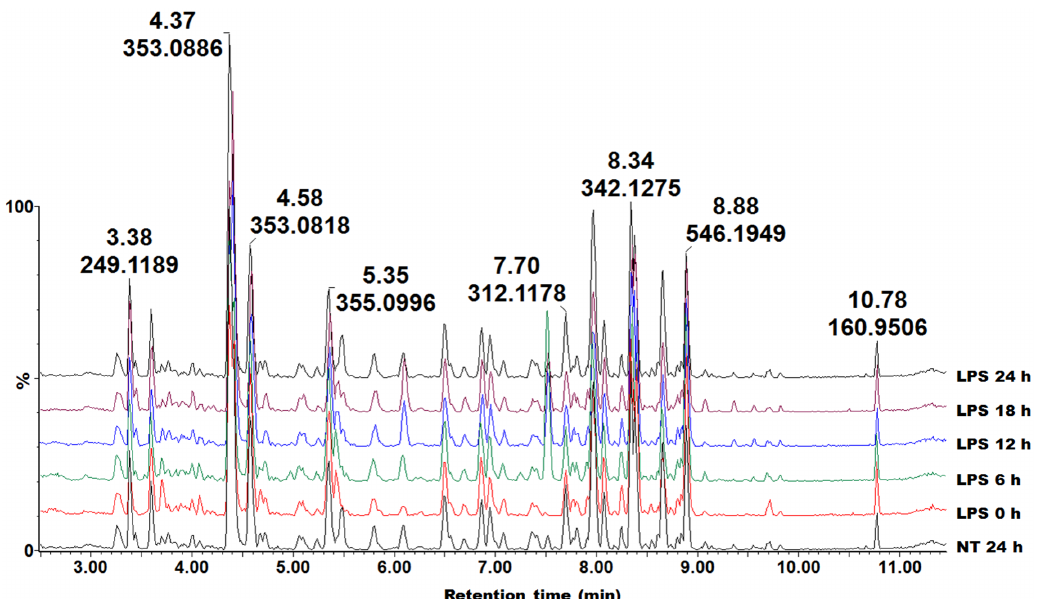
Fig 1. UHPLC-MS BPI chromatograms (ESI - ) of methanol extracts of tobacco cells treated with LPS. The extracts were prepared from cells harvested at different time intervals (0 – 24 h). NT 24 h is a non-treated sample incubated for 24 h. The chromatograms show time-dependent changes, reflecting metabolic changes over